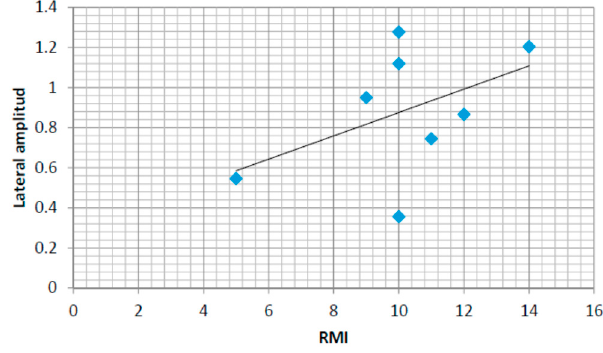
Figure 16. Rivermead Mobility Index (RMI) and lateral amplitude in the normalized pressure pattern.